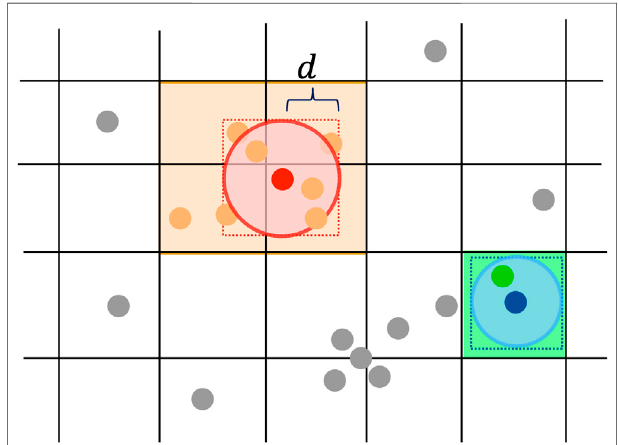
FIGURE 1 | 2D points are indexed with a grid for fast neighborhood query in CLUE. Construction of this spatial index only involves registering the indicesofpointsintothebinsofthegridaccordingtopoints ’ 2Dspatialpositions. Toqueryd-neighborhood N d ( i ) de fi nedin Eq.2 ,takingthered(blue)point forexample,we fi rstlocateits Ω d ( i ) de fi nedin Eq.1 ,asetofallpointsinthebins touched by a square window [ x i ± d , y i ± d ] . The [ x i ± d , y i ± d ] window is shown as the orange (green) square, while Ω d ( i ) is shown as orange (green) points. Then, we examine points in Ω d ( i ) to identify those within a distance d from point i , shown as the ones contained in the red (blue)